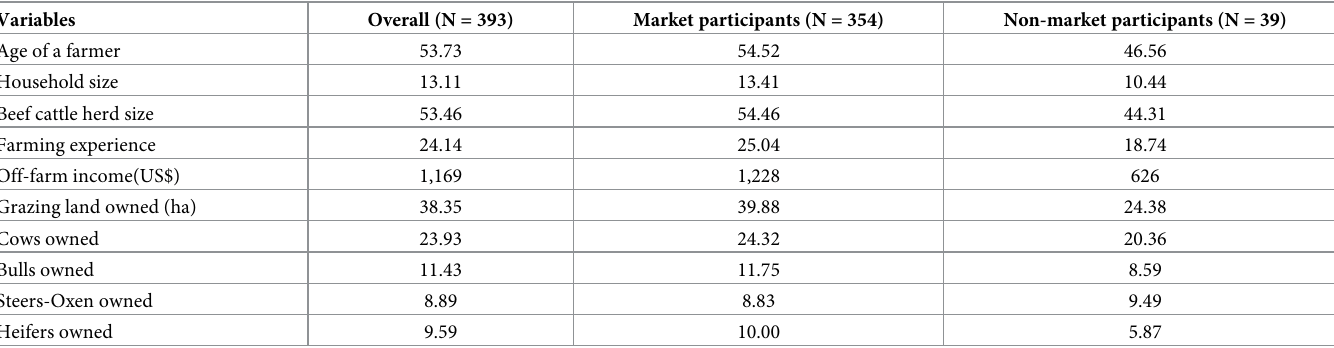
Table 3. Comparison of socioeconomic characteristics of market and non-market participants based on the average scores of continuous